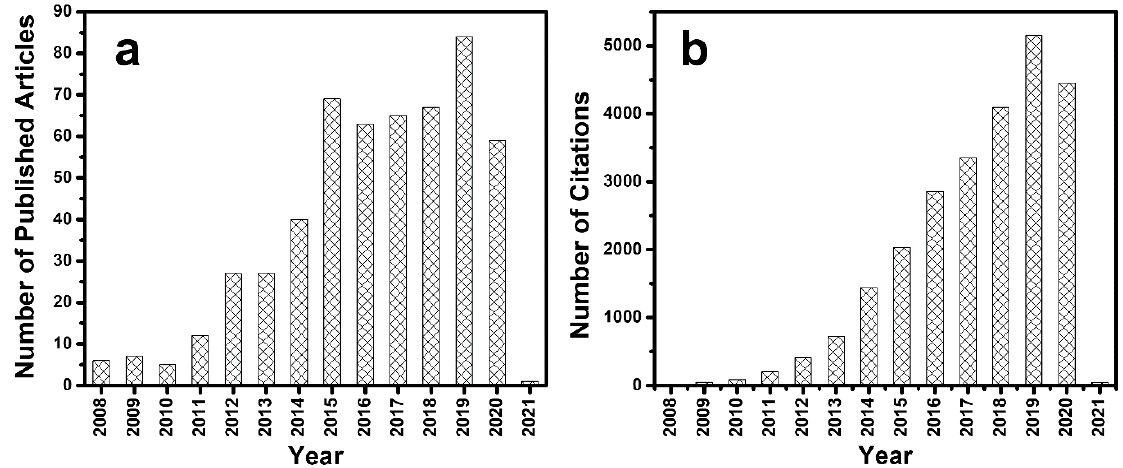
Figure 2. ( a ) Number of articles published and ( b ) number of citations since 2008 with topic keywords “BiOX” and “photocatal*” adapted from the Web of Science, dated 17 November 2020.